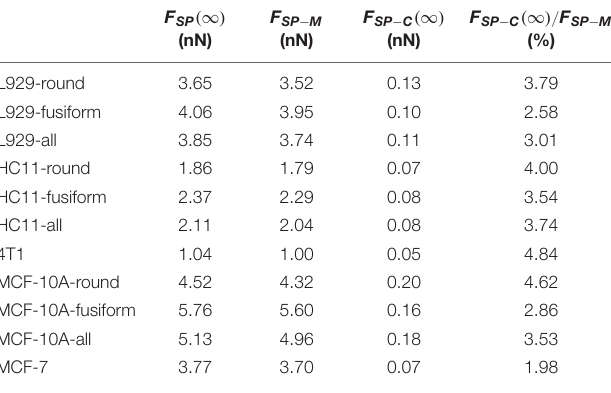
TABLE 1 | Values of force applied to an AFM probe after relaxation F SP ( ∞ ) , force provided by the membrane F SP − M and force provided by the cytoskeleton network F SP − C ( ∞ ) for cells with different adherent